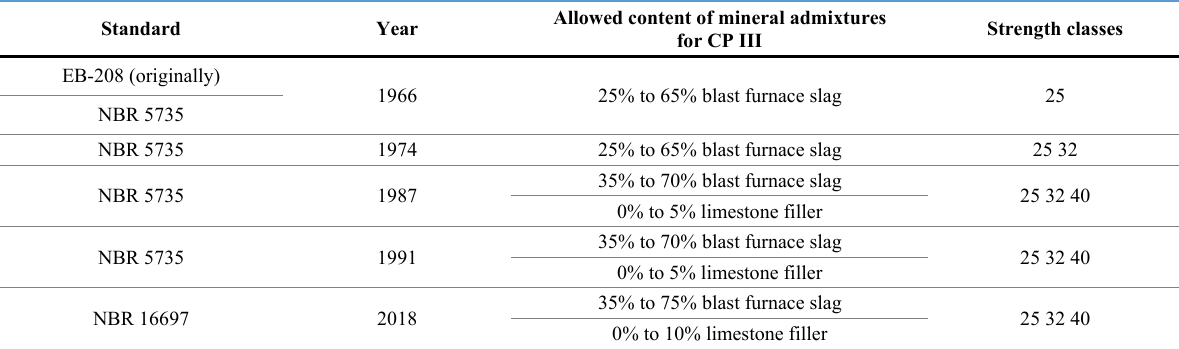
Table 3. Evolution of standardisation of the Portland Blast-Furnace slag cement (CP III) in Brazil, in terms of maximum clinker + calcium sulphate replacement in mass.